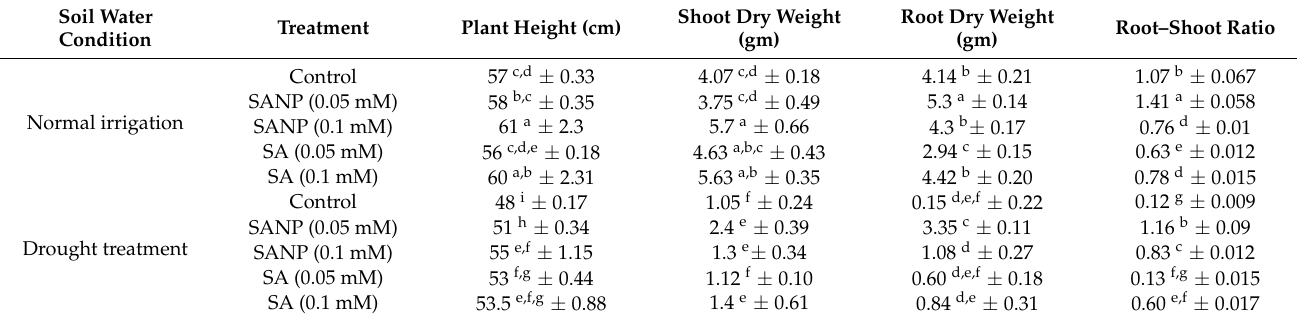
Table 2. Effect of drought stress, bulk SA, and SANPs on plant height, shoot dry weight, root dry weight, and root–shoot ratio.